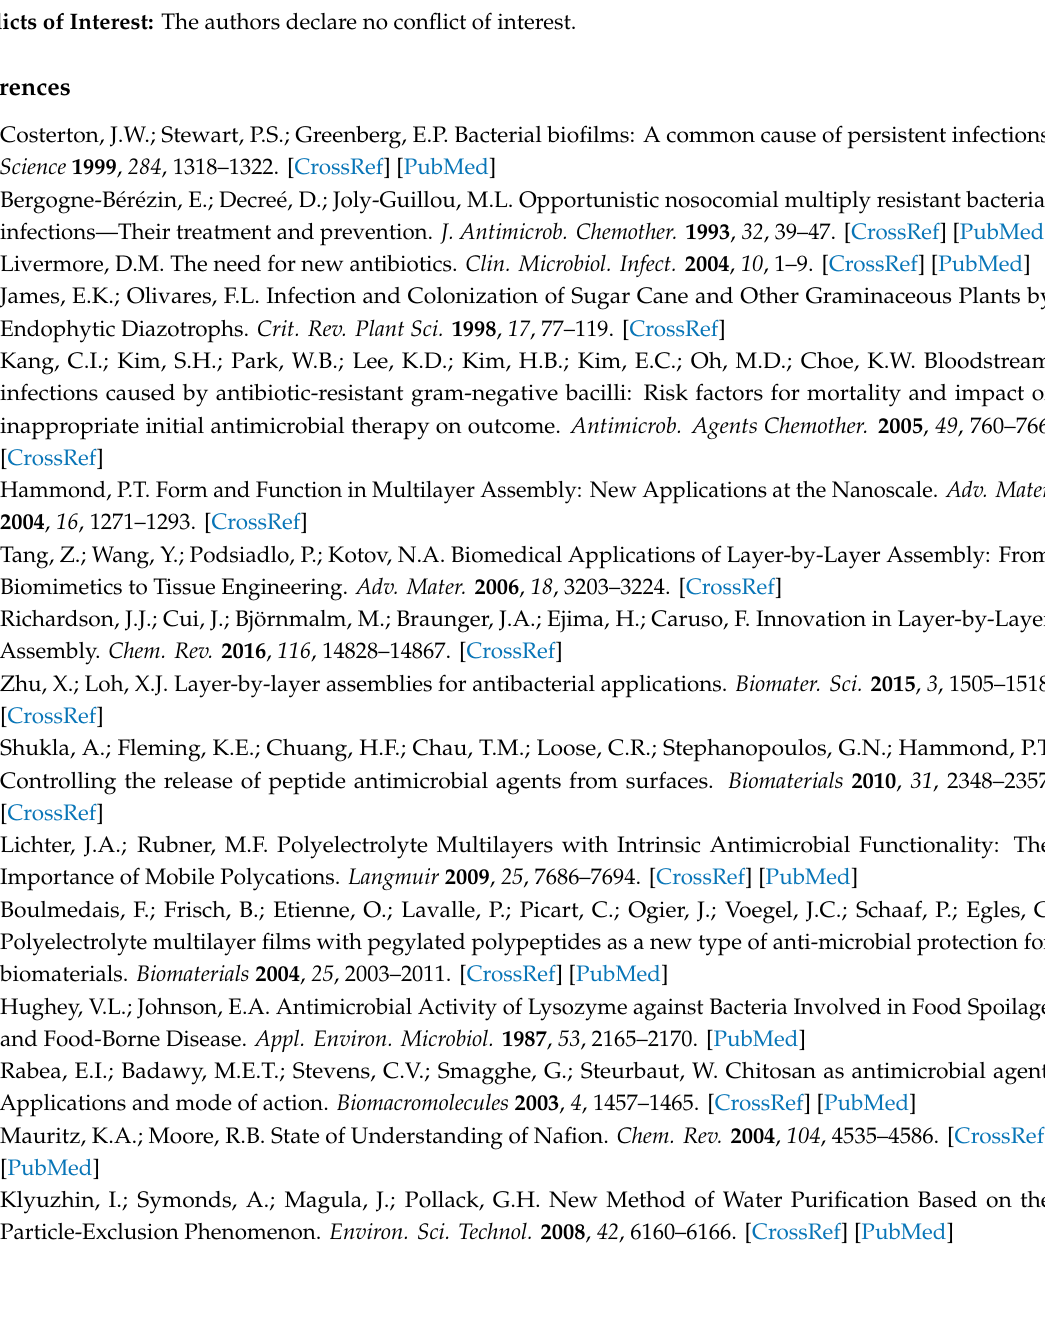
Figure S1: (i) Photos of UV-vis polystyrene cuvettes: Uncoated (A), (Naf / Lys) 6 (B), (Naf / Chi) 6 (C), (Naf / Lys / Naf / Chi) 2 (D), demonstrating their transparency levels. (ii) UV-vis spectra of polystyrene cuvettes coated with (Naf / Lys) 6 , (Naf / Chi) 6 , and (Naf / Lys / Naf / Chi) 2 . Figure S2: Reduction of the population of E. coli and S. aureus cultures exposed to QCM-D crystals coated with (Naf / Lys) 6 (pH = 4), (Naf / Lys) 6 (pH = 9), (Naf / Lys) 3 (pH = 9), (Naf / Lys) 3.5 (pH = 9), (Naf / Lys / Naf / Chi) 1 , and (Naf / Chi) 3